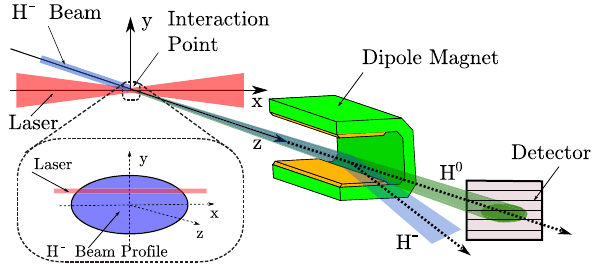
FIG. 1. Schematic principle of a laserwire emittance scanner. A fraction of the H − particle beam collides with photons of a focused laser beam. The neutralized H 0 are detected by a downstream detector after being separated from the main beam by a dipole magnet. By measuring the H 0 profile at the detector plane for different laser y-positions, the angular spread and ultimately the transverse phase-space can be reconstructed.